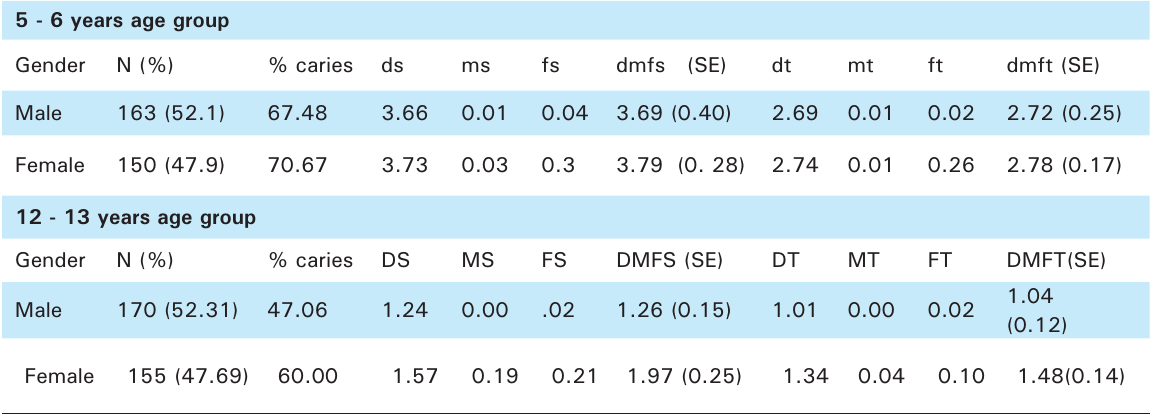
Table 2. Dental caries status in the 5 - 6 years and 12 - 13 years age group by gender